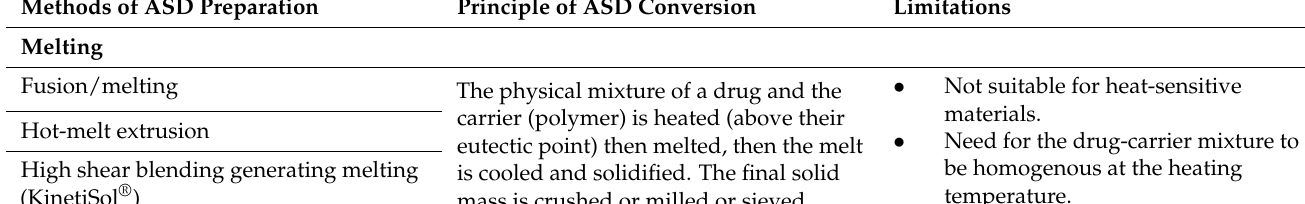
Table 3. Overview of the Methods/Technologies for ASD preparations and limitations of use. Methods of ASD